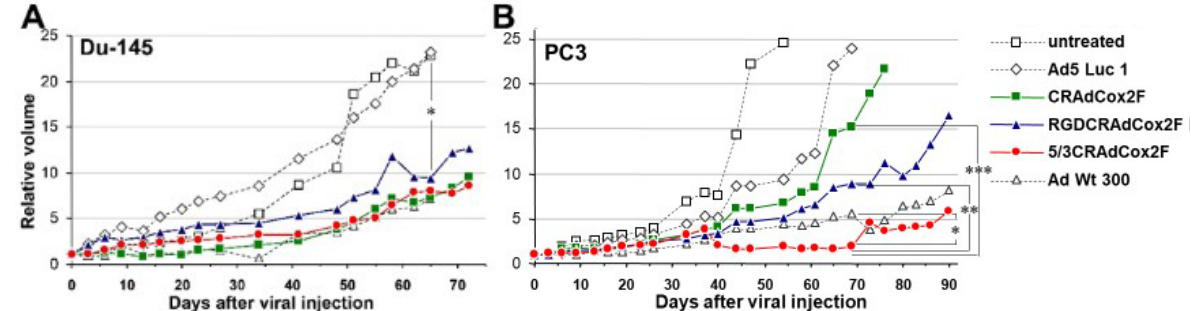
Figure 4. In vivo antitumor effect in subcutaneous xenograft model. The in vivo antitumor effect of COX-2 CRAds was analyzed in Du-145 ( A ) and PC3 ( B ) hormone-refractory prostate cancer cell lines. Subcutaneous xenografts in nude mice were treated with a single intratumoral injection of 5 × 10 9 vp of each virus in 100 µL PBS. The tumor volume was shown as the relative volume compared to day 0. In Du-145, both the untreated group and the group with nonreplicative control virus had to be terminated due to the size of the tumors on day 65, while the control groups were sacrificed on day 54 and 69, respectively. For the Du-145 xenograft, the CRAd Cox2F, RGDCRAdCox2F, 5/3CRAdCox2F, and AdWt groups started to show significant tumor suppression compared to the nonreplicative control group starting on day 65. In PC3 xenografts, CRAdCox2F and RGD CRAd Cox2F showed a slight antitumor effect, but it was not significant when compared to the untreated or nonreplicative control groups. The size of the tumors treated with chimeric 5/3CRAdCox2F and AdWt was significantly reduced ( p < 0.05) compared to that in the nonreplicative control group from day 44. The group with 5/3CRAdCox2F showed significant tumor suppression ( p < 0.05) compared to the group with CRAdCox2F or RGD CRAd Cox2F from day 40 to the end of the experiment. At day 69, the relative tumor volume of the 5/3CRAdCox2F group was significantly smaller than that of the groups with CRAdCox2F, RGDCRAdCox2F, and AdWt. * p < 0.05, ** p < 0.01, *** p <